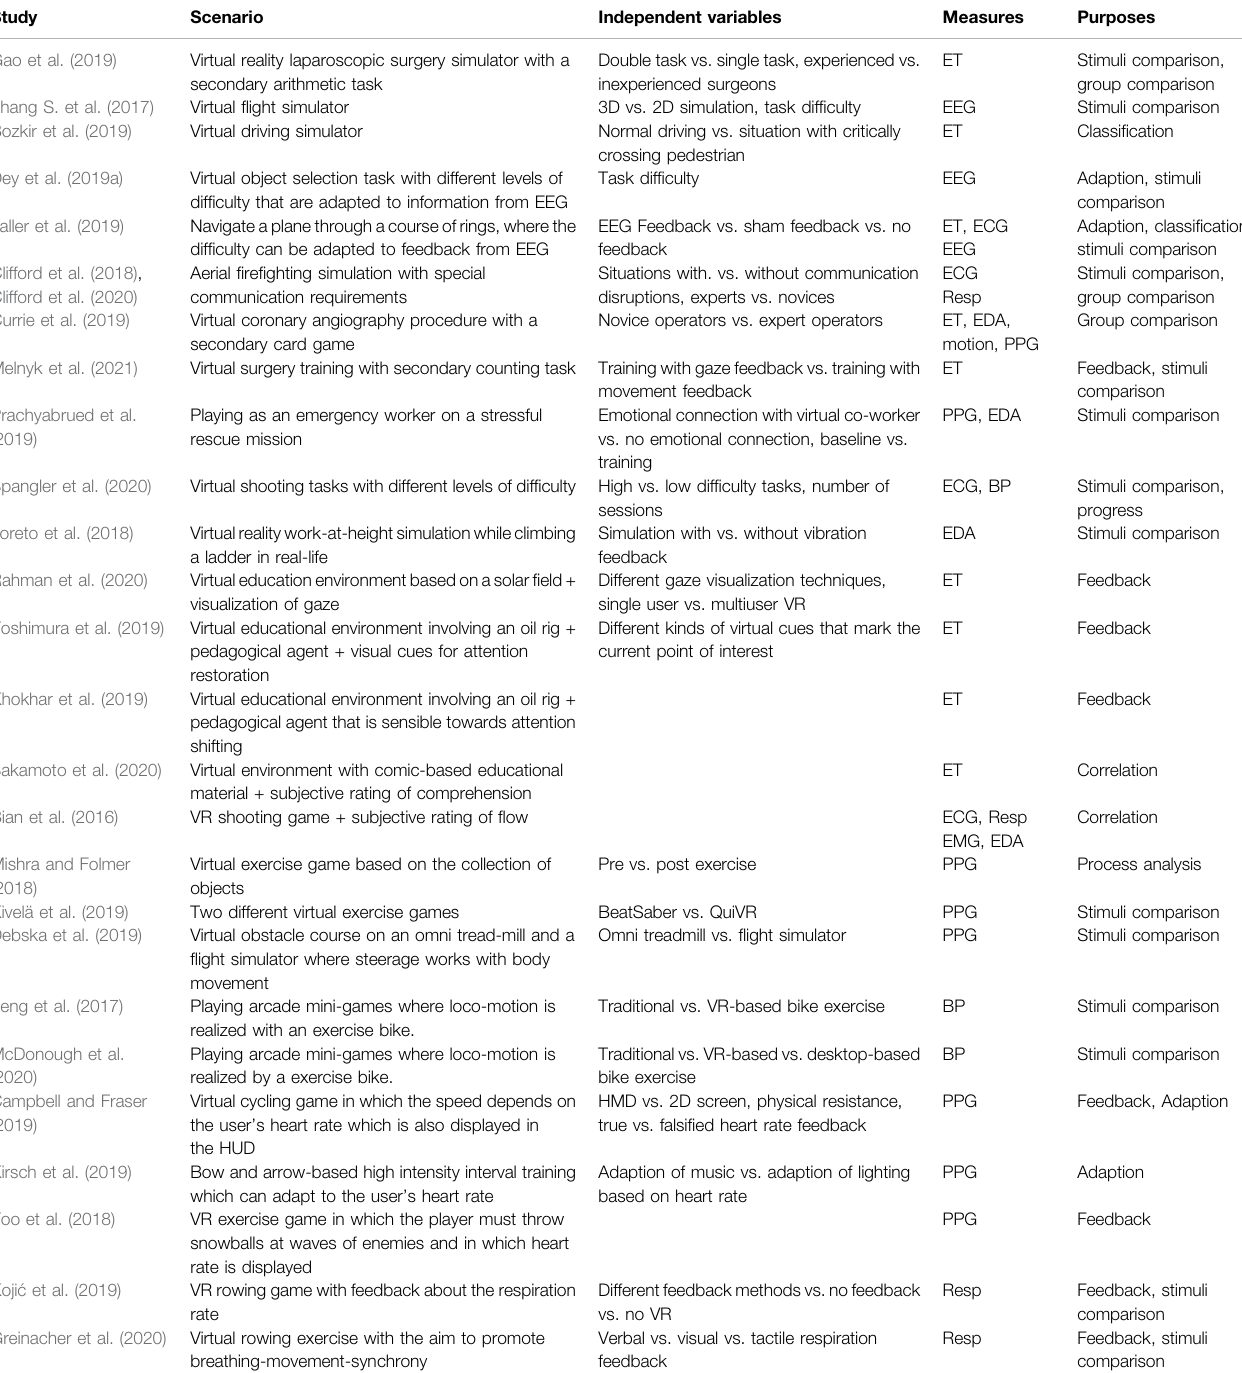
TABLE 6 | Overview of the works from the fi eld of training and education that were discussed in Section 4.1.2 . The Measures column refers to the physiological measures usedinthework.TheentriesoftheIndependentVariablescolumnoftendonotcovereverythingthatwasconsideredinthework.EntriesinthePurposescolumnreferto the categories listed in Section 4.1.2